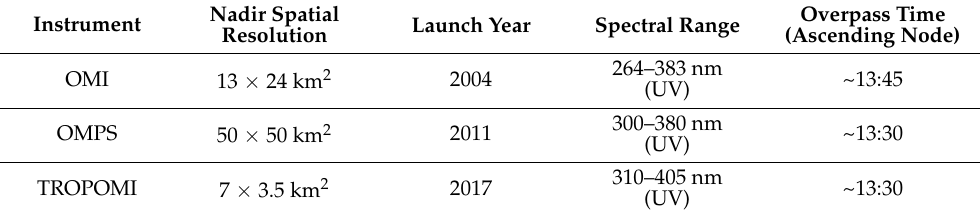
Table A1. Summary of the main features of the Ozone Monitoring Instrument (OMI), Ozone Mapping and Profiler Suite (OMPS), and Tropospheric Monitoring Instrument (TROPOMI) instruments used in this study. The nadir spatial resolution corresponds to the area of a single pixel.